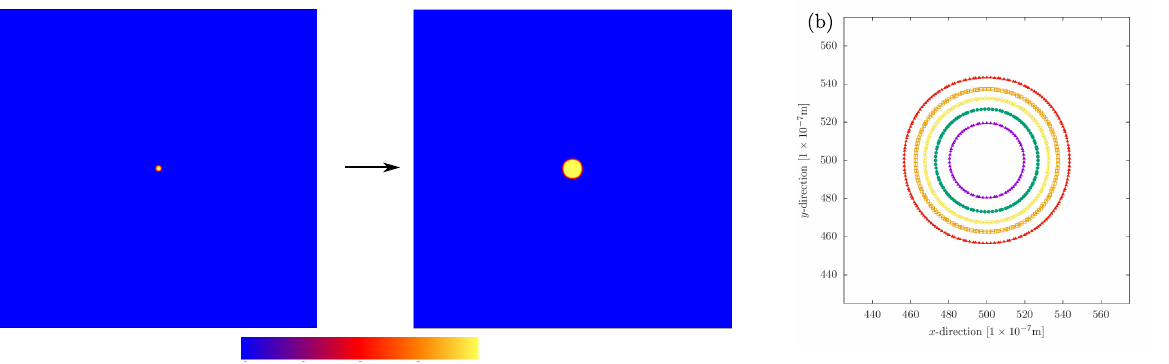
Figure 8. ( a , b ) Simulation screenshots and phase-field isolines for an isotropic spherical seed. As the interfacial curvature varies linearly with its arc length, the absence of tip splitting is also captured. This phenomenon is in complete accordance with the sharp-interface analytical prediction, which is defined by the absence of crest and trough regions. The color bar illustrates the phase-field according to the legend embedded below the simulation snapshots. Left to right simulation frames, as well as the phase-field isolines, indicate the evolution of the spherical seed with